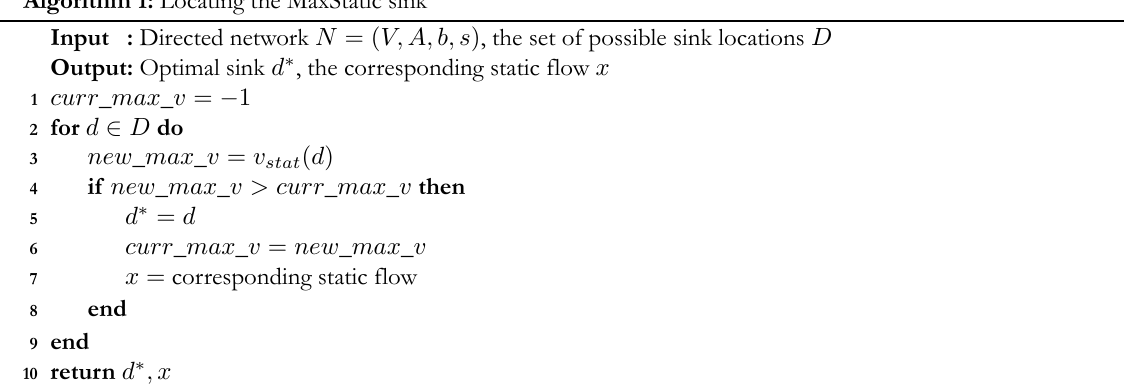
Algorithm 1: Locating the MaxStatic